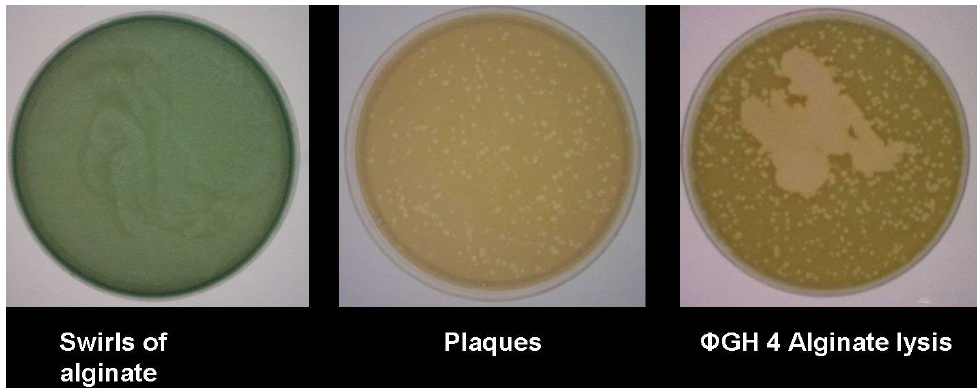
Figure 3. Expression of alginase in bacteriophage-infected Pseudomonas aeruginosa